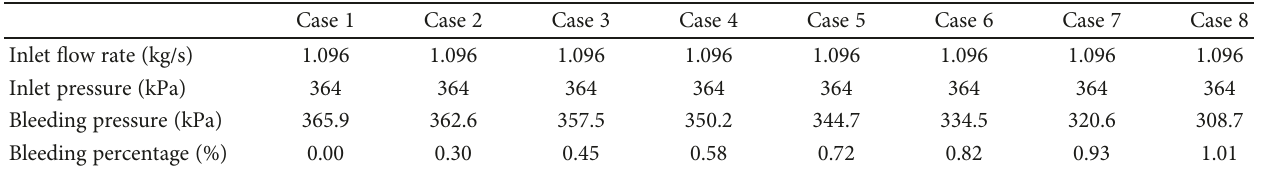
Table 3: Operating conditions ( H